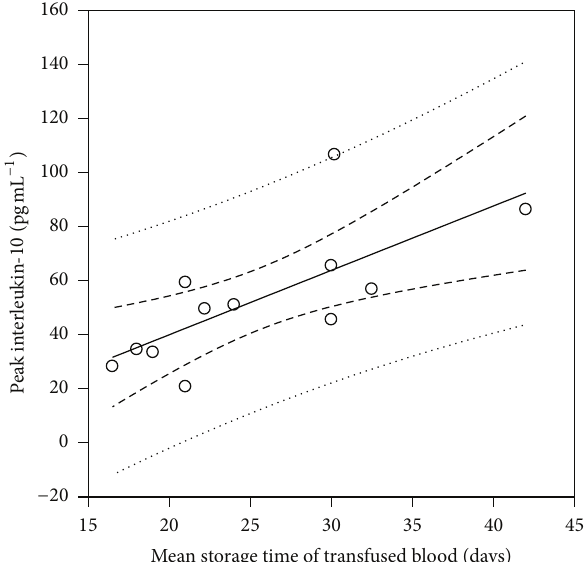
Figure 3: Scatter plot diagram of peak postoperative IL-10 values versus the mean duration of storage of transfused blood (in days).